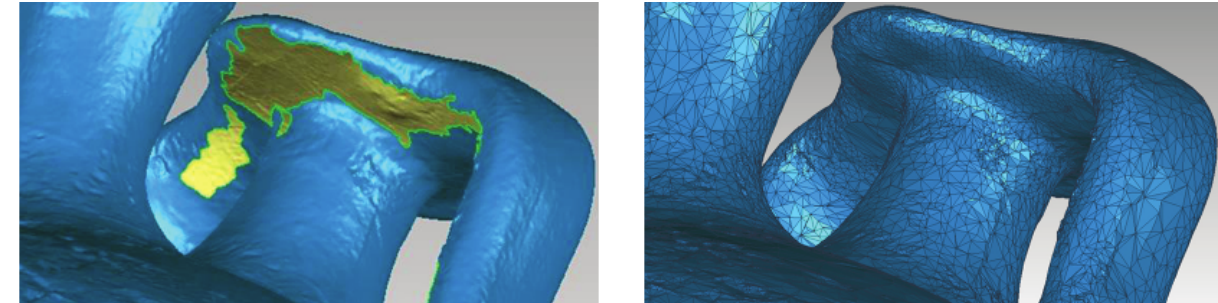
Figure 11. Model of a stirrup jar, before and after holes fi